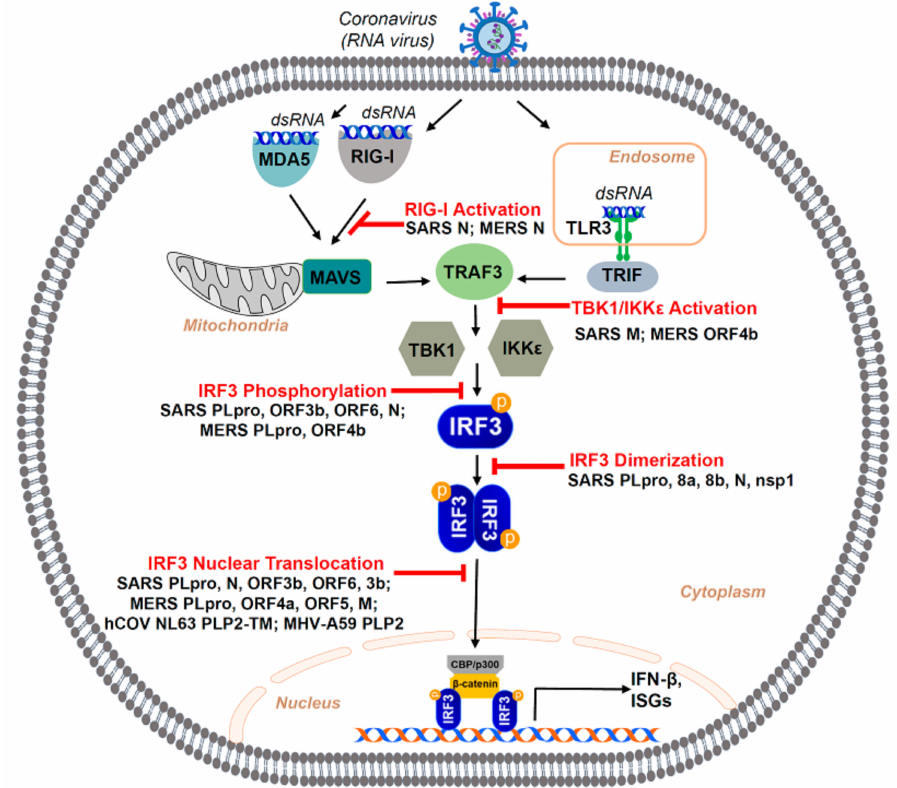
Figure 4. SARS-coronavirus (SARS-CoV) mediated inhibition of IRF3 activation. The SARS-CoV has various proteins that play a role in antagonizing IRF3 activation as a defense mechanism. Its nucleocapsid (N protein) acts by inhibiting RIG-I activation, one of the major PRRs responsible for IRF3 activation. Matrix (M) protein of SARS inhibits the activation of kinases (TBK-1, IKK ε ) required to activate IRF3. Various accessory proteins (Orf 3b, 6), protease (PLpro), as well as the N protein of the virus can antagonize the phosphorylation and activation of IRF3 itself. Even after IRF3 activation, SARS-CoV can use several accessory proteins (8a, 8b, 3b, 6) and non-structural proteins (nsp1) or the N-protein to block major changes, such as IRF3 dimerization or its nuclear translocation, that are essential for IRF3 to transcribe its downstream antiviral genes successfully. Some of these activation steps are also inhibited by MERS-CoV proteins, as shown in the